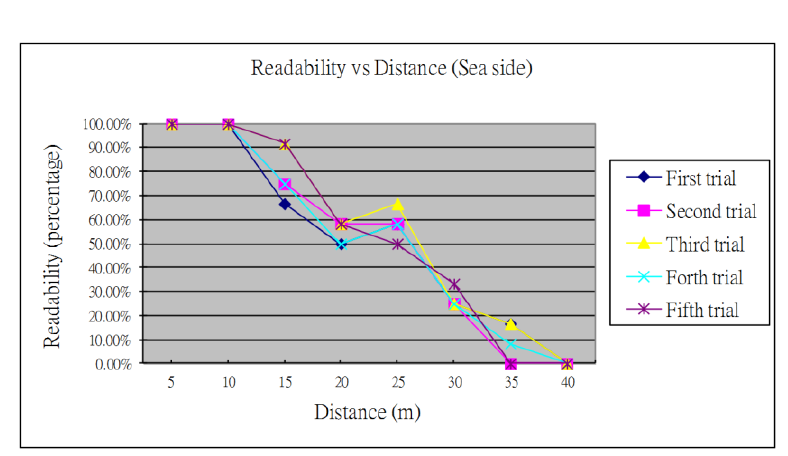
Figure 13. Relationship between readability and distance in Sea Side